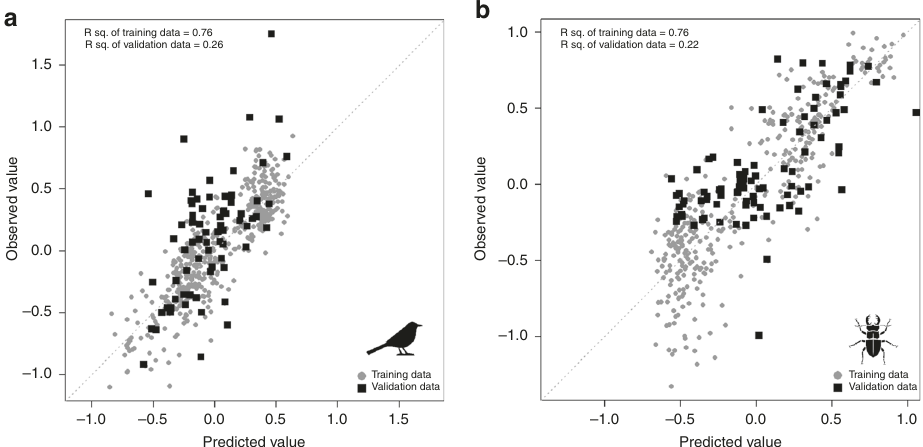
Fig. 4 External validation of the assemblage composition models. Scatter plots of the fi rst axis of the NMDS of a birds and b saproxylic beetles, between the observed and predicted value of the training data (grey circles) and the validation data (black squares). The R ² (the coef fi cient of determination) of training data and validation data are shown. Source data are provided as a Source Data fi